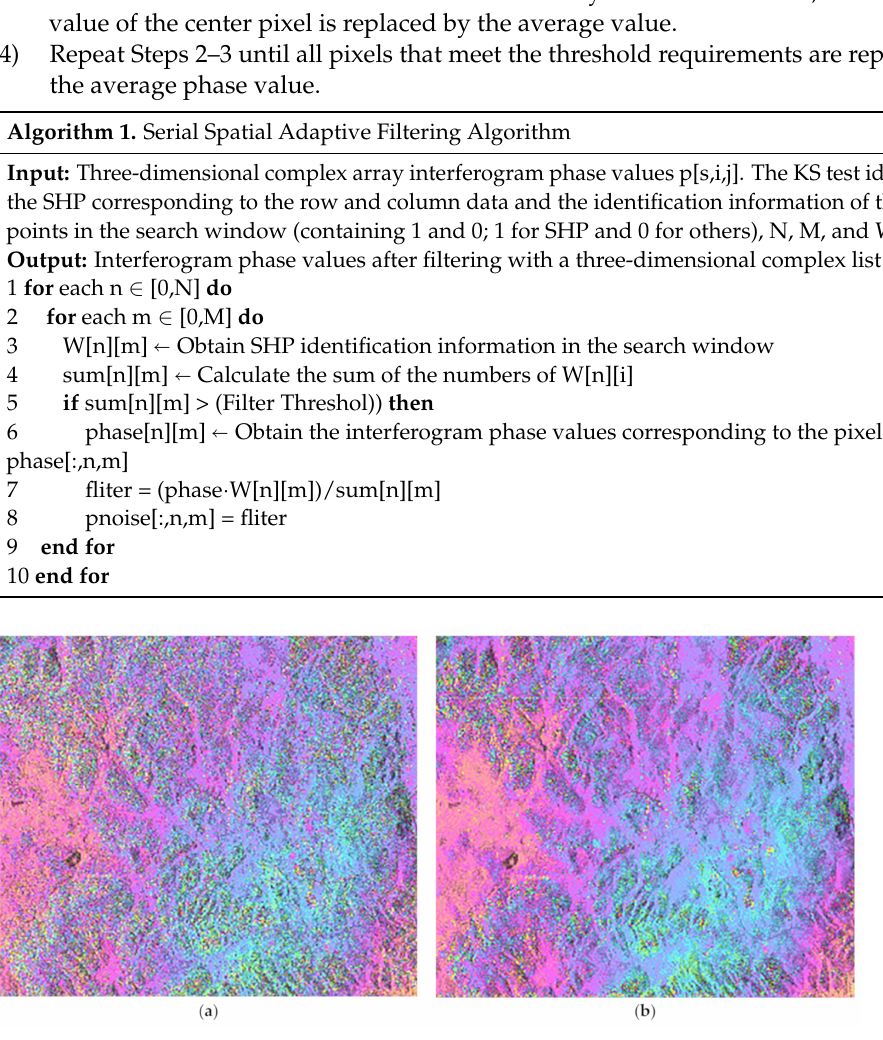
Figure 1. Comparison before and after filtering: ( a ) before filtering and ( b ) after filtering (the resultant figure is after cropping a differential interferogram in the study